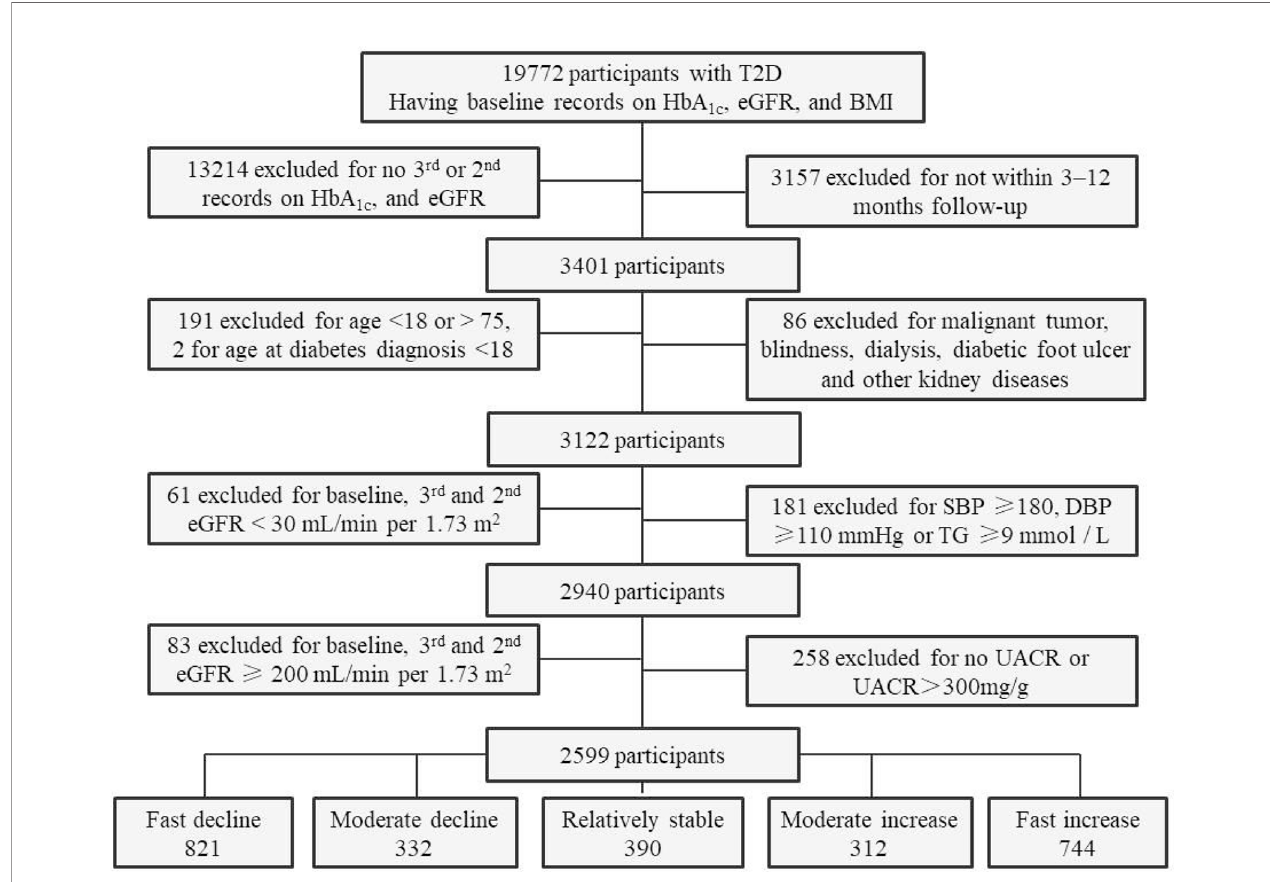
FIGURE 1 | Flowchart and sample size of participants for the fi nal analyses. T2D, type 2 diabetes; eGFR, estimated glomerular fi ltration rate; BMI, body mass index; SBP, systolic blood pressure; DBP, diastolic blood pressure; TG, triglyceride; UACR, urinary albumin-to-creatinine